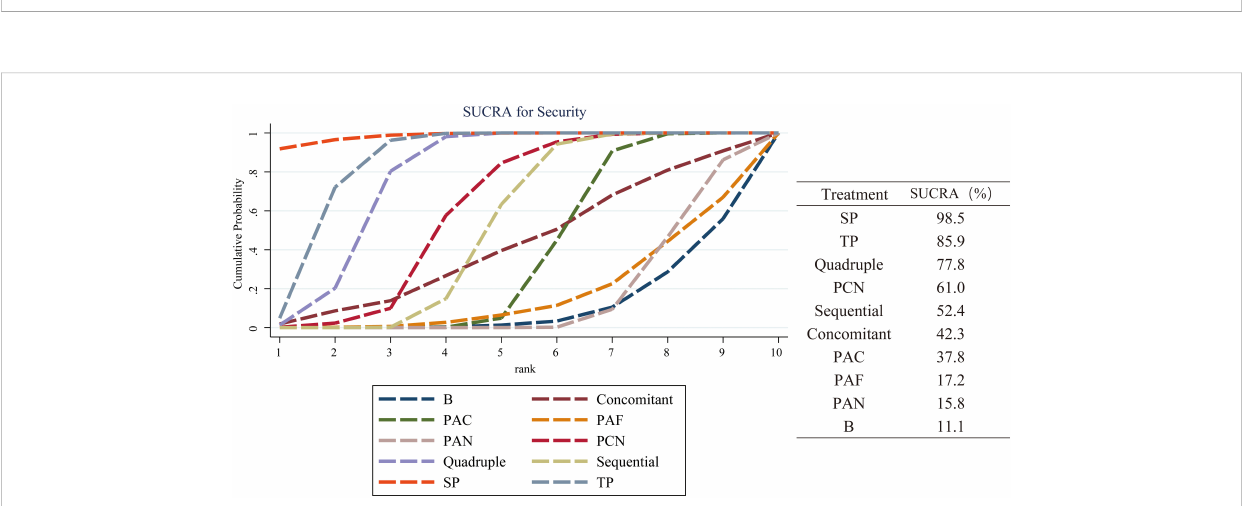
FIGURE 6 Safety evaluation of 10 regimens in children with H. pylori Infection. Taking total side effects rate as the safety index of the eradication scheme, the larger the SUCRA value and the area under the curve, the higher the security of the regimens. Regimen labels: B, bismuth-containing triple therapy; Concomitant, concomitant therapy; PAC, PPI, amoxicillin and clindamycin; PAF, PPI, amoxicillin and furanes; PAN, PPI, amoxicillin and nitroimidazoles; PCN, PPI, clindamycin and nitroimidazoles; Quadruple, quadruple therapy; Sequential, sequential therapy; SP, sequential therapy with probiotics; TP, triple therapy with probiotics.